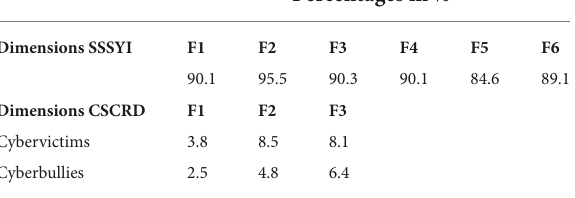
TABLE 5 Mann–Whitney U for cybervictims and cyberbullies according to